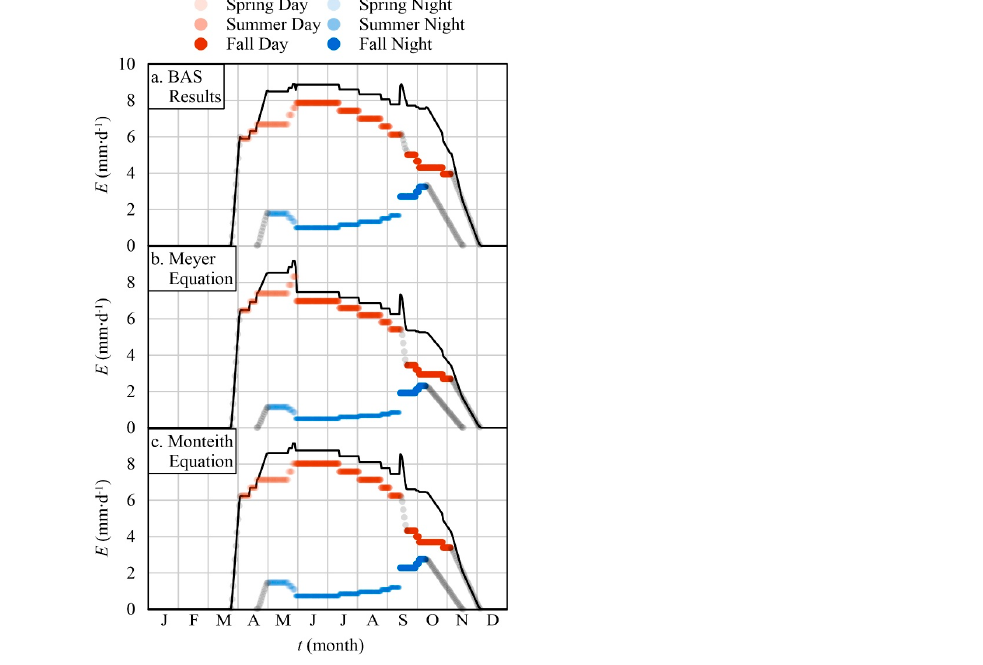
Figure 8. Predicted evaporation for the study area using: ( a ) BAS results; ( b ) Meyer equation; and ( c ) Monteith equation.